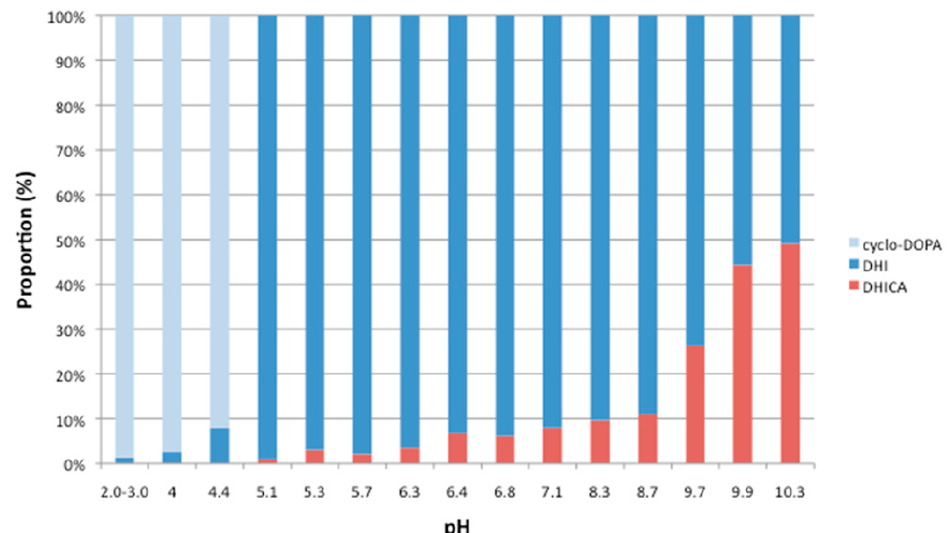
Figure 3. The products distibutions of the decomposition of cycloDOPA ( 8 ) at different pH levels. CycloDOPA ( 8 , 35 mg) was dissolved in D 2 O (0.5 mL) and CH 3 CN (1 µ L), and the solution was adjusted to the indicated pH with a NaOD solution. The incubation time refers to the time required for cycloDOPA to be consumed completely, expected pH = 3.6 and pH = 4.4.